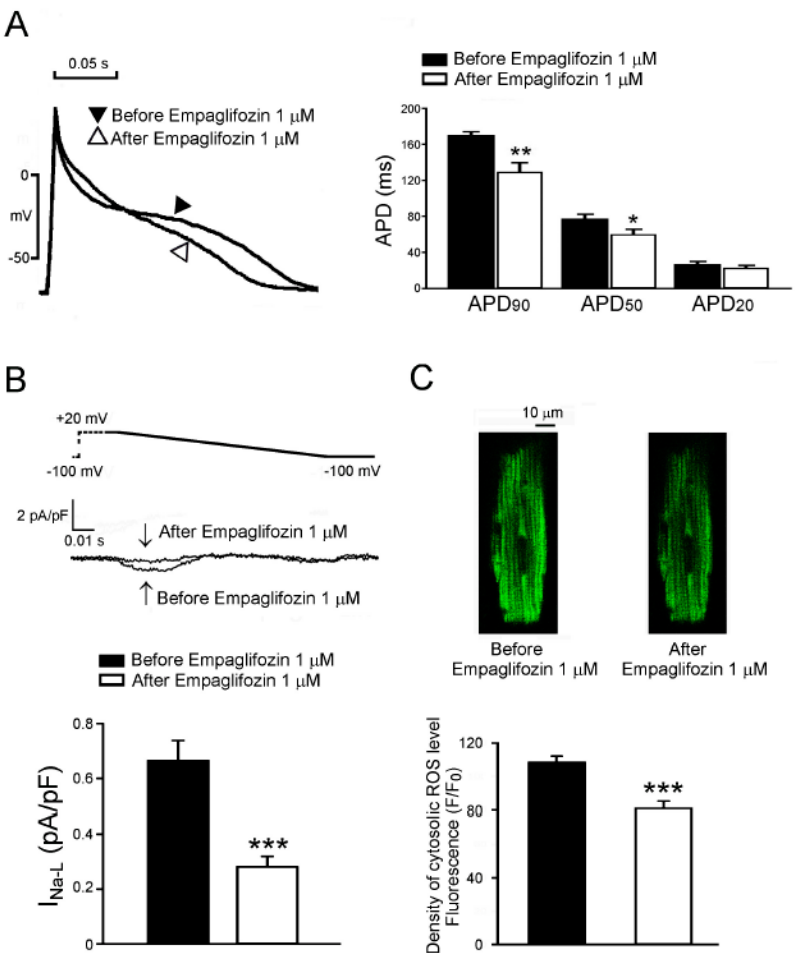
Figure 6. Acute effects of empagliflozin on DM ventricular myocytes. ( A ) The superimposed tracings and average data ( n = 10) of AP morphology before and after acute administration of empagliflozin (1 µ M) in DM rat ventricular myocytes. ( B ) Representative superimposed tracing of current and average data ( n = 11) of the I Na-Late before and after acute administration of empagliflozin (1 µ M) in DM rat ventricular myocytes. ( C ) An example and average data ( n = 11) of cytosolic levels of reactive oxygen species (ROS) before and after acute administration of empagliflozin (1 µ M) in DM rat ventricular myocytes. * p < 0.05; ** p < 0.01; *** p < 0.005 versus before empagliflozin.